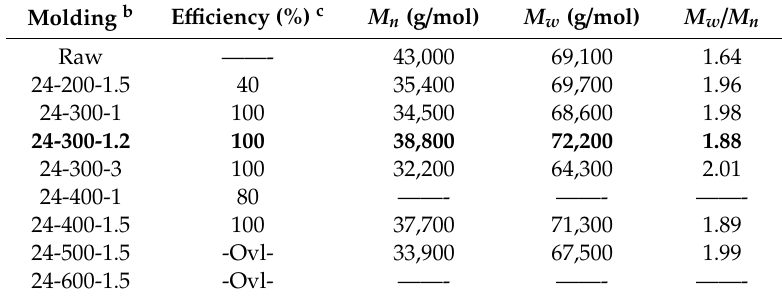
a Bold characters indicate the optimized conditions and the corresponding measurements. b Micro-molding conditions: Amplitude ( µ m), force (N) and time (s). c Mold filling, qualitative evaluation (i.e., 8 half pieces or 4